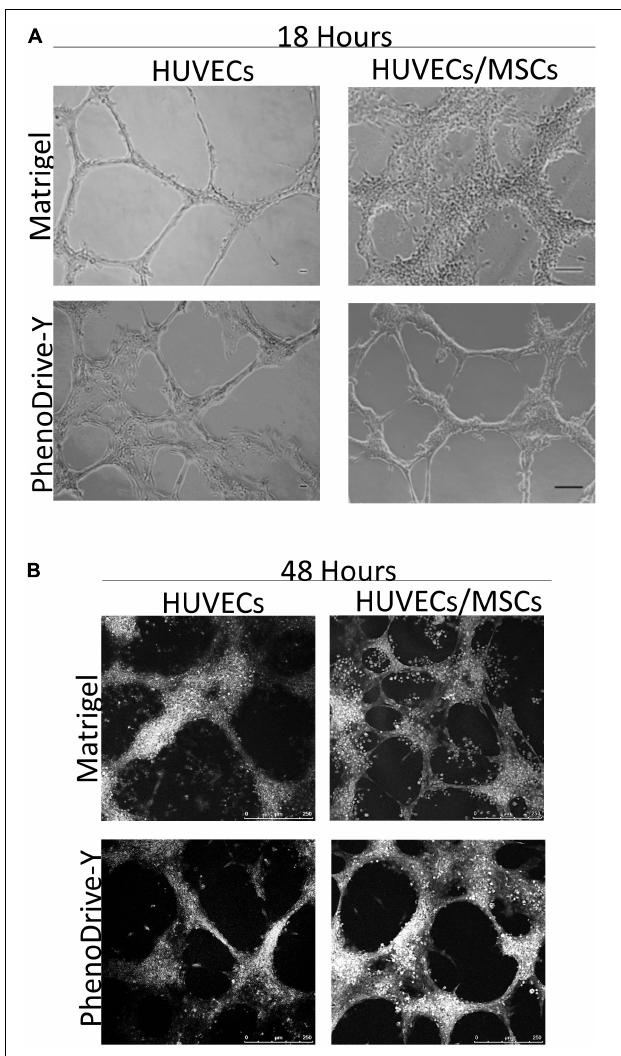
FIGURE 1 | (A,B) Tubule formation of human umbilical vascular endothelial cells (HUVECs) and HUVECs/mesenchymal stromal cells (MSCs) grown on Matrigel and PhenoDrive-Y after 18 h (A) and 48 h (B) incubation. Light microscopy: scale bar , 100 µ m; RGB bright-field confocal microscopy: scale bar , 250 µ